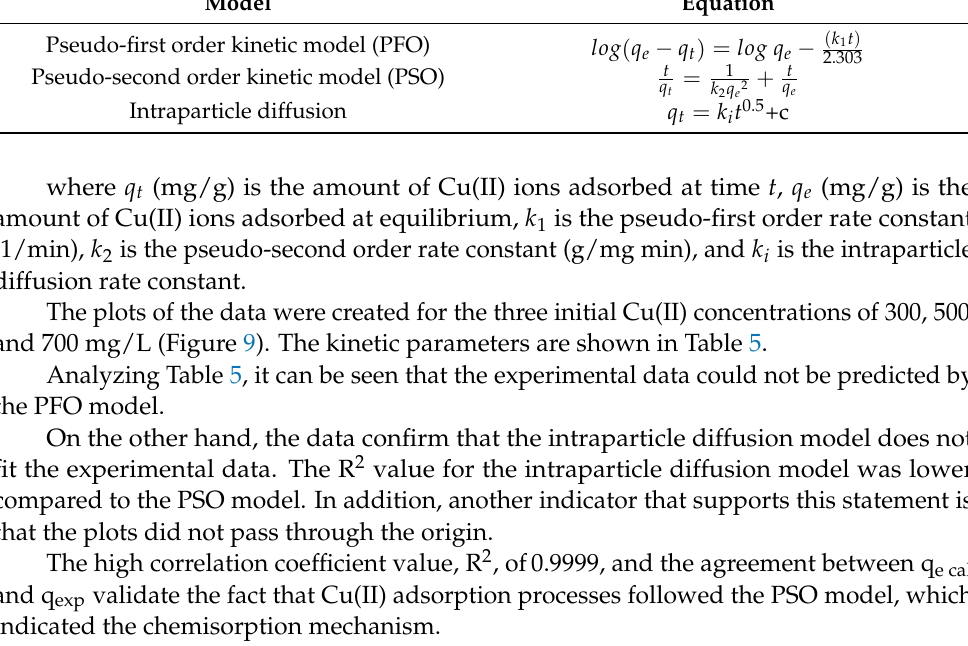
Model Equation Pseudo-first order kinetic model (PFO) log ( q e − q t ) = log q e − ( k 1 t ) Pseudo-second order kinetic model (PSO) Intraparticle